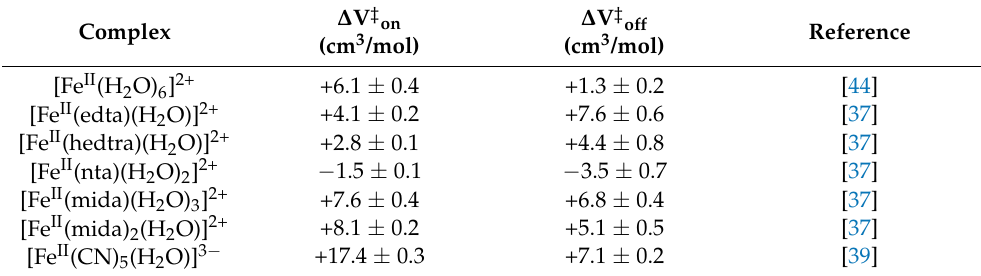
Table 2. Summary of activation-volume data for the reversible coordination of NO by a series of Fe II (L) complexes, where L represents a series of polyaminocarboxylate